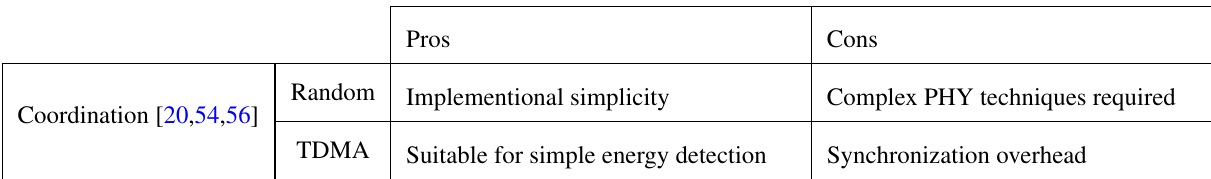
Table 4. Sensing scheduling